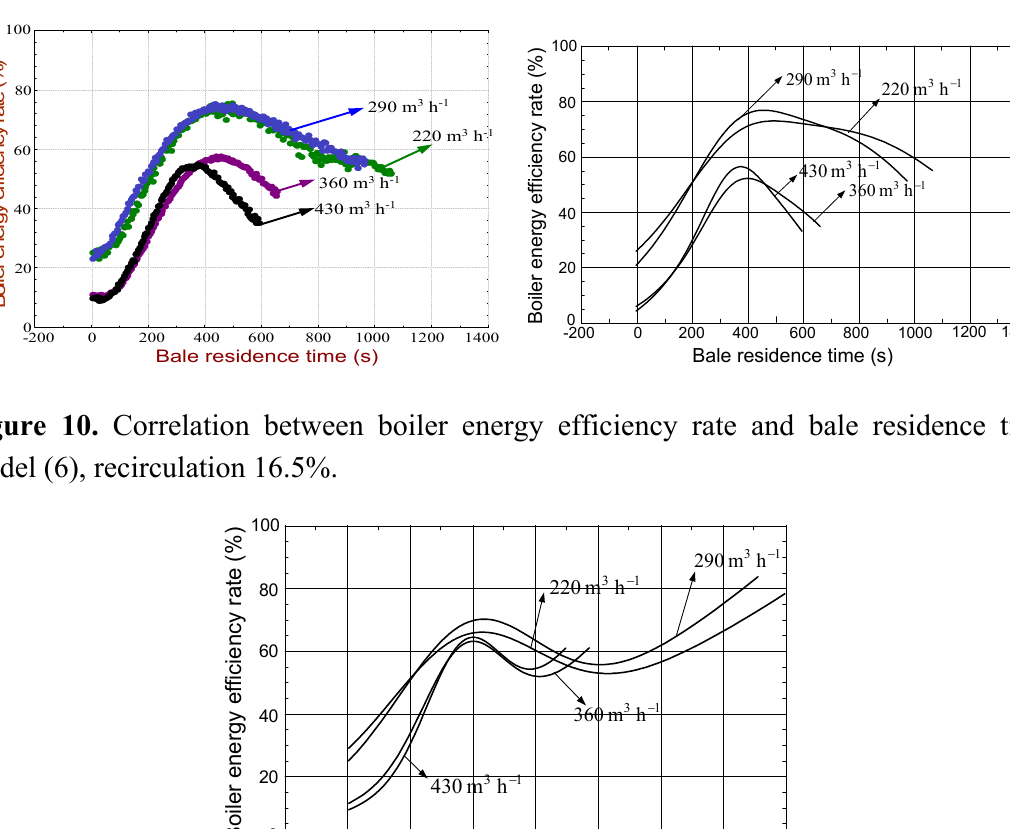
Figure 9. ( a ) Correlation between boiler energy efficiency rate and bale residence time, experimental data, recirculation 0%. ( b ) Correlation between boiler energy efficiency rate and bale residence time, model (5), recirculation 0%.